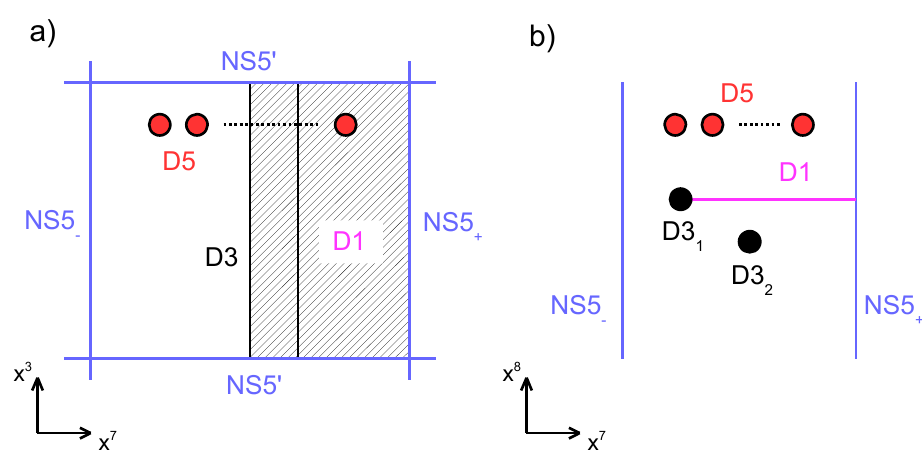
Figure 1 . Brane setup realising the insertion of the abelian monopole u e in the x 37 plane and in the x 78 plane (in this case the NS5’ branes span the whole plane). source of Fermi mulitplets. If the con(cid:12)guration reached has no D1 strings left, we simply have Z = (cid:26);(cid:27)